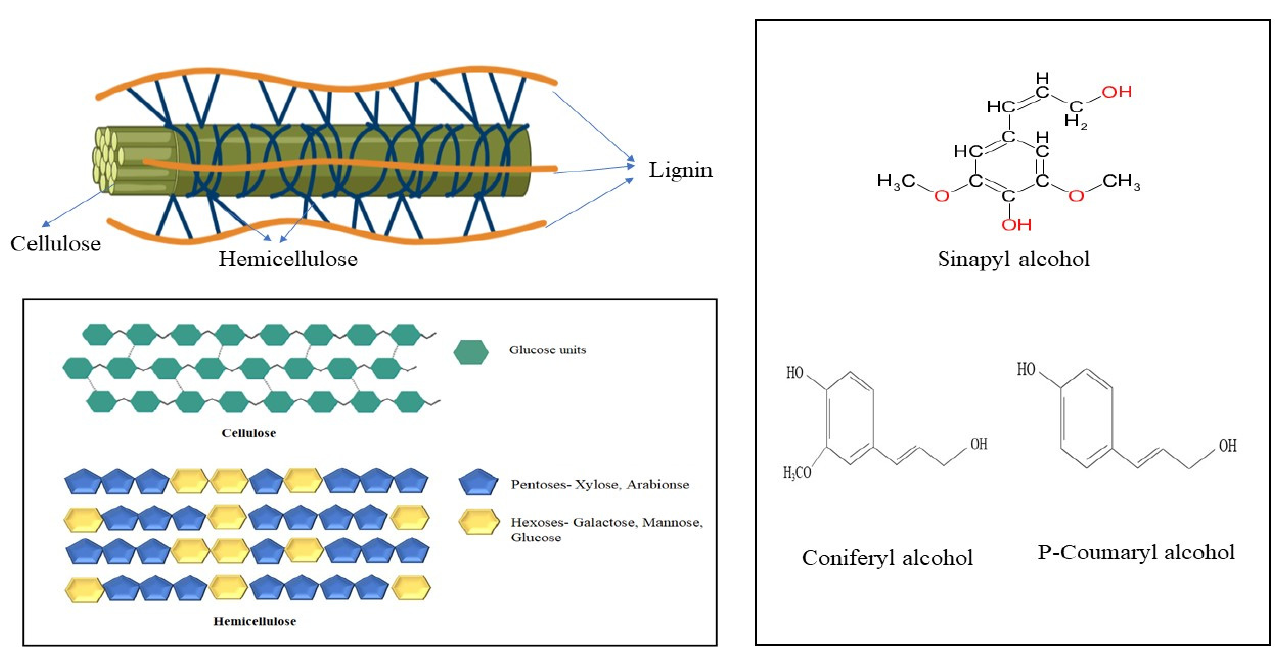
Figure 1. Components of lignocellulosic materials.